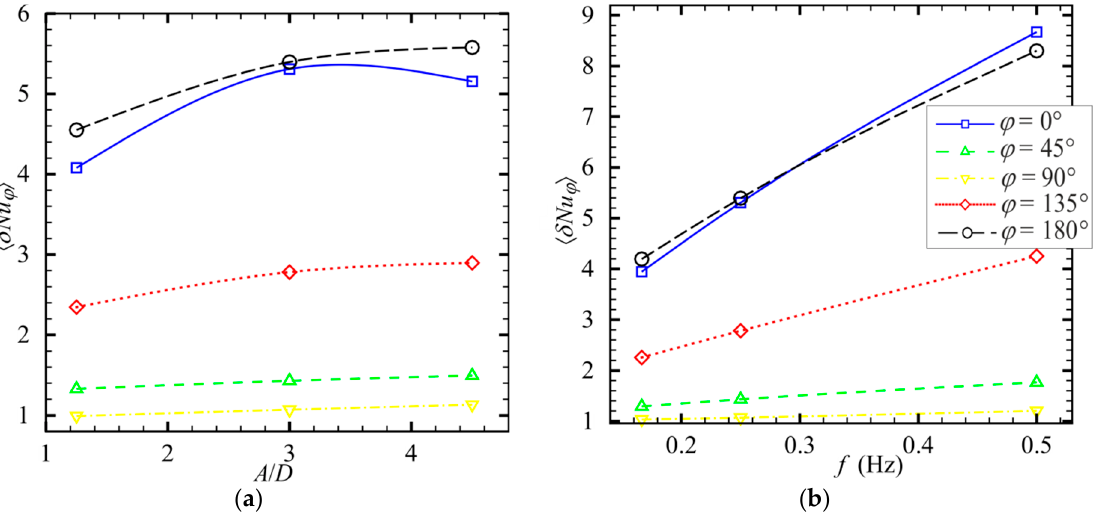
Figure 12. The effect of pulsations on the local Nusselt number. ( a ) Variation in the Nusselt number ratio δ Nu φ = Nu φ , p / Nu φ , st with A / D at f = 0.25 Hz. ( b ) Variation of δ Nu φ = Nu φ , p / Nu φ , st with f at A / D = 3.